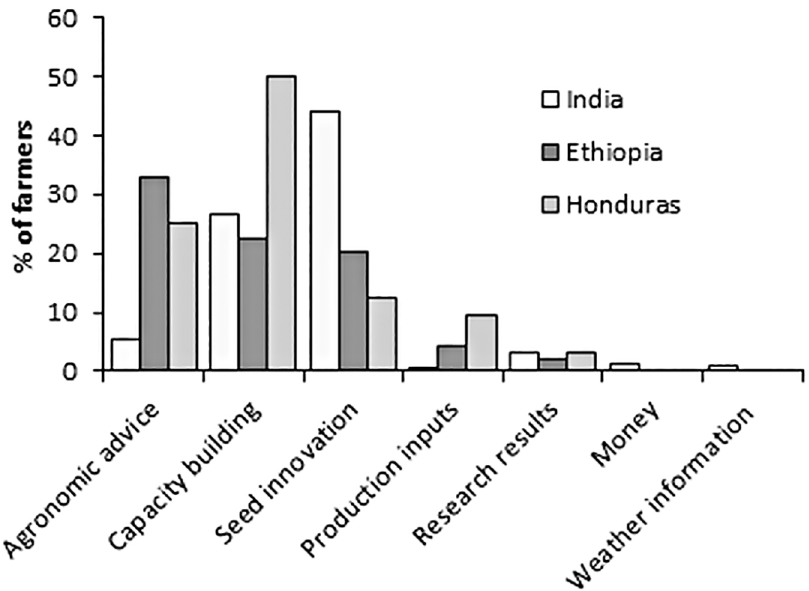
Fig 5. Factors which farmersexpected from the citizen science process in return for their